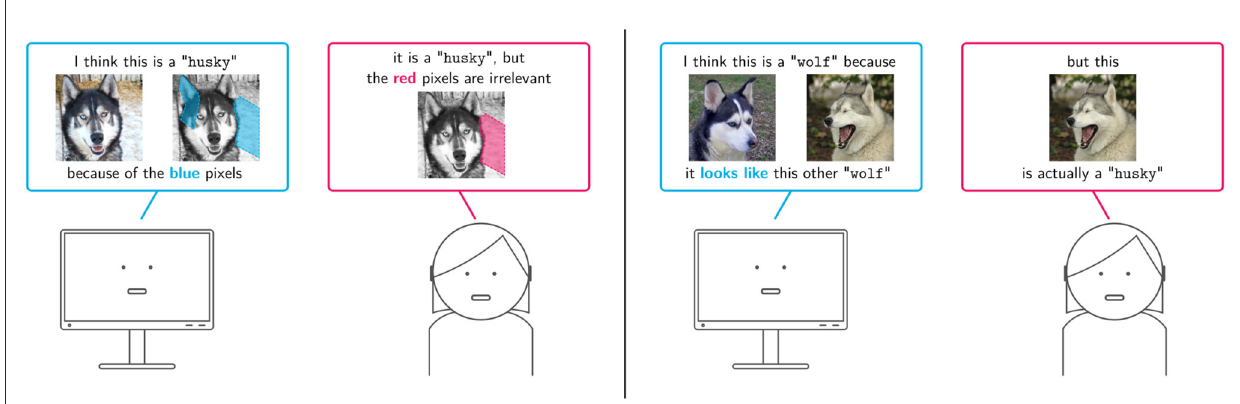
FIGURE2 Illustration of two explanation strategies based on local explanations. (Left) The machine explains its predictions by highlighting relevant input variables —in this case, relevant pixels—and the user replies with an improved attribution map. (Right) The machine justifies its predictions in terms of training examples that support them, and the user either corrects the associated label. In both cases, the data and model are aligned to the user’s